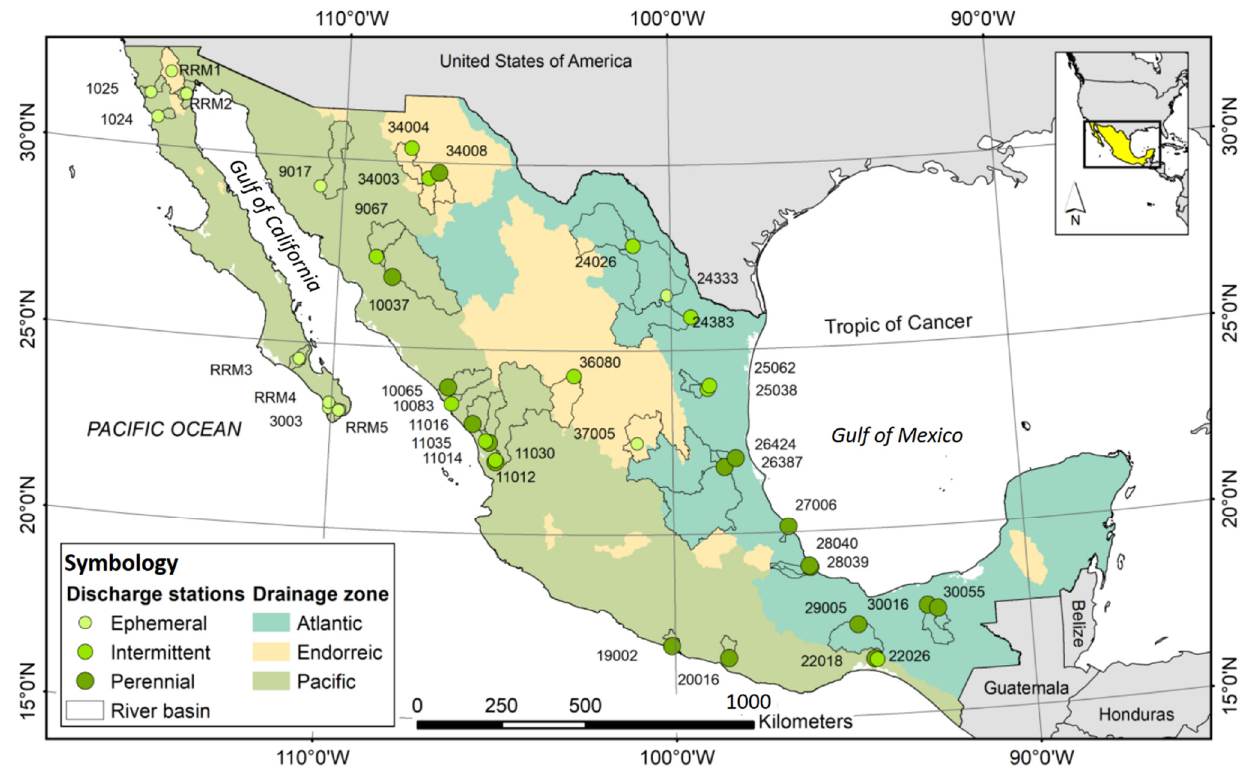
Figure 1. Location of basins, gauging stations, and codes of the study river sites per drainage zone.